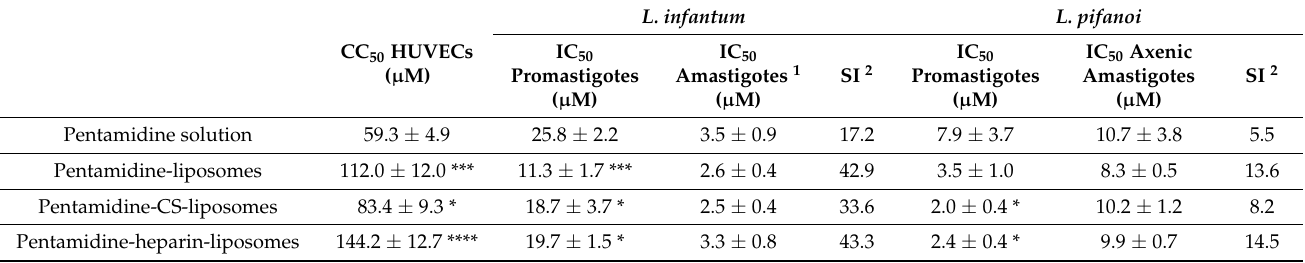
Table 3. IC 50 , CC 50 and selectivity index (SI, CC 50 /IC 50 ) for pentamidine in solution or loaded in liposomes. Mean values ± standard deviations are reported ( n = 3).